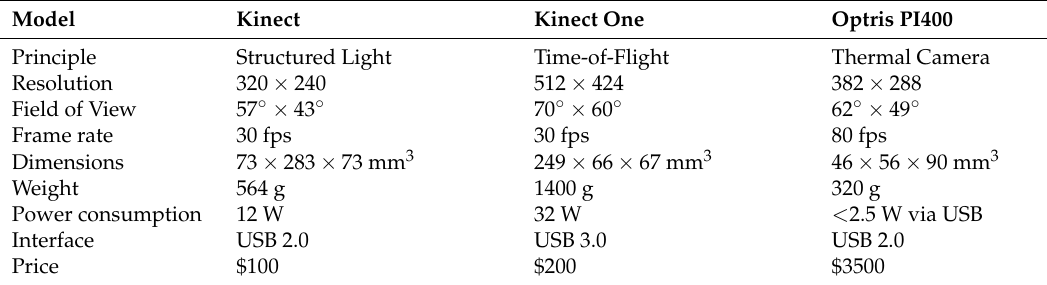
Table 2. Property table of used sensors: The three sensors are selected for the body weight estimation because of their similar FOV, which provides a total view of the patient on the stretcher. For the 3D sensors, the measurement range is sufficient. The frame rate of at least 30 Hz is acceptable, while the thermal camera provides a frame rate of 80